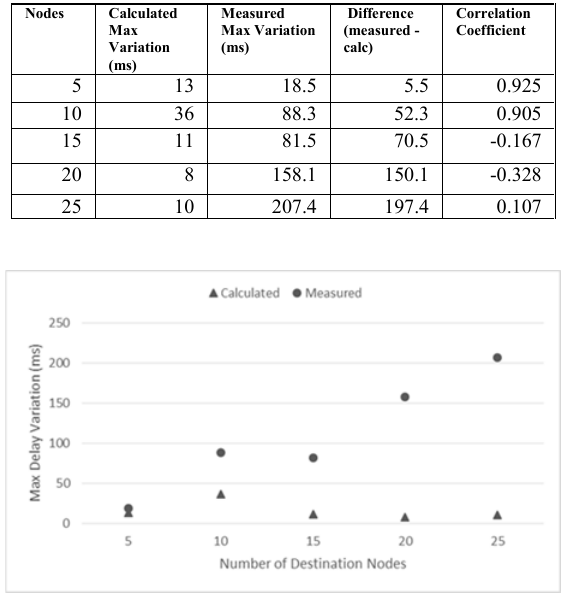
Table 1: Comparison of Maximum Delay Variations for Calculated and Measured Values